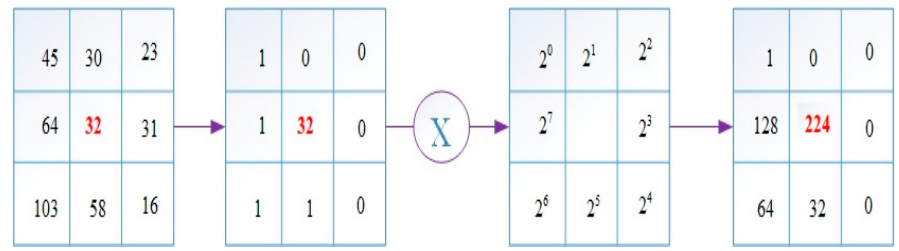
Figure 2. LBP operator working steps.